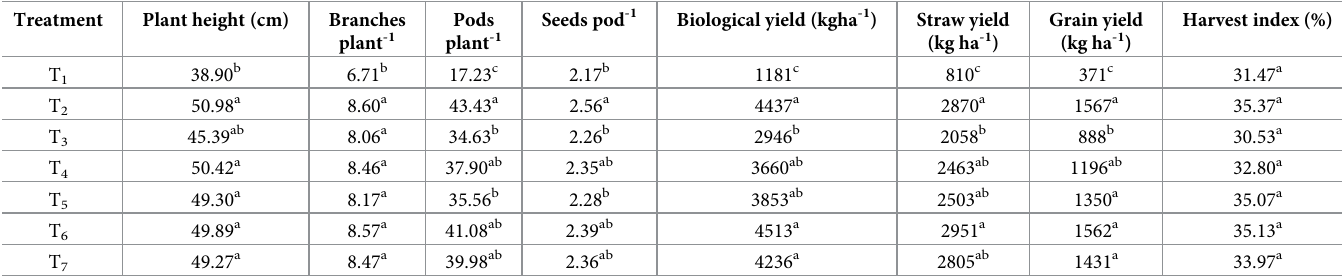
Table 3. Effect of different weed management practices on crop growth, yield attributes and yields. Treatment Plant height